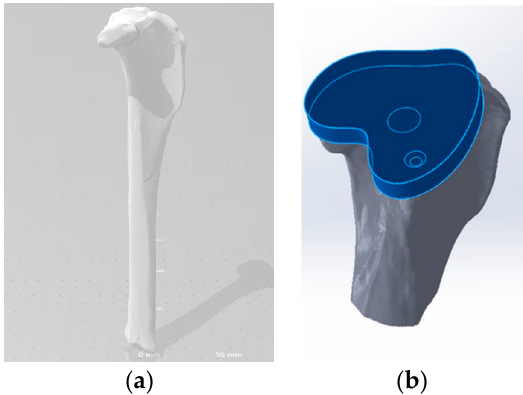
Figure 1. Process to model a tibial tray (TT) from a canine tibia bone. ( a ) CT scan model of a SAWBONES canine tibia and ( b ) Geometric modeling of a tibial tray from a proximal tibia end profile.